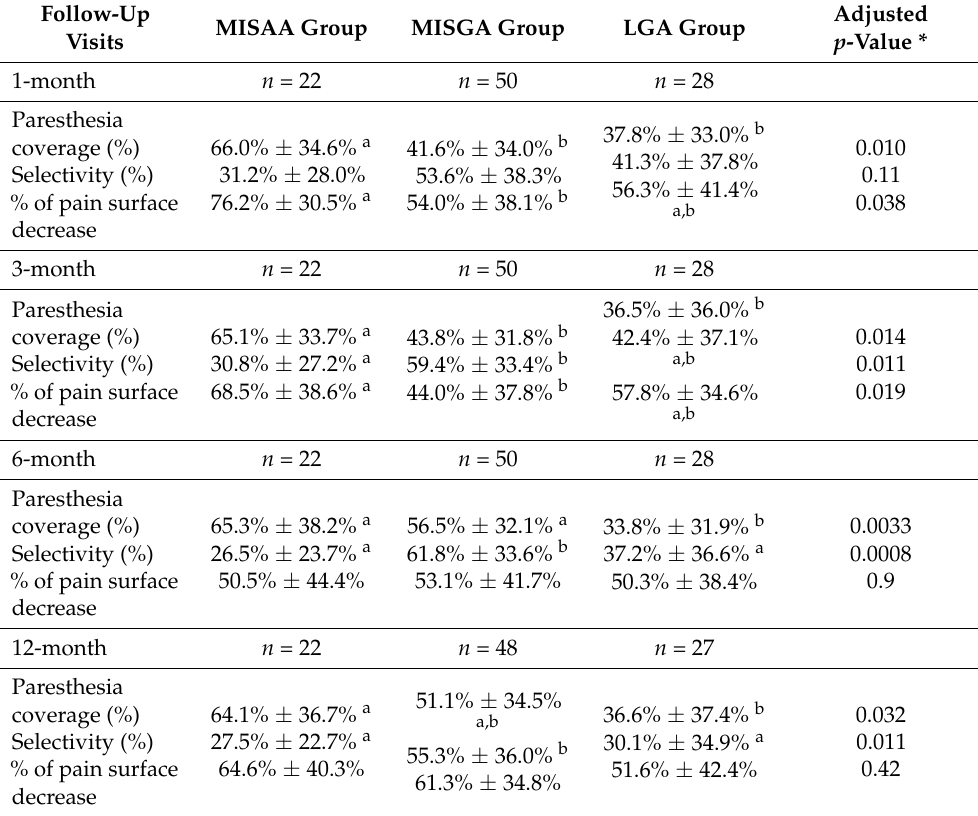
Table 3. Comparison of the pain mapping outcomes among the MISAA, MISGA and LGA groups at the 1-, 3-, 6- and 12-month